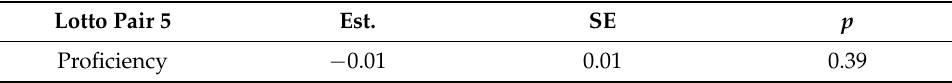
Table 12. Proficiency effect on choice for lottery